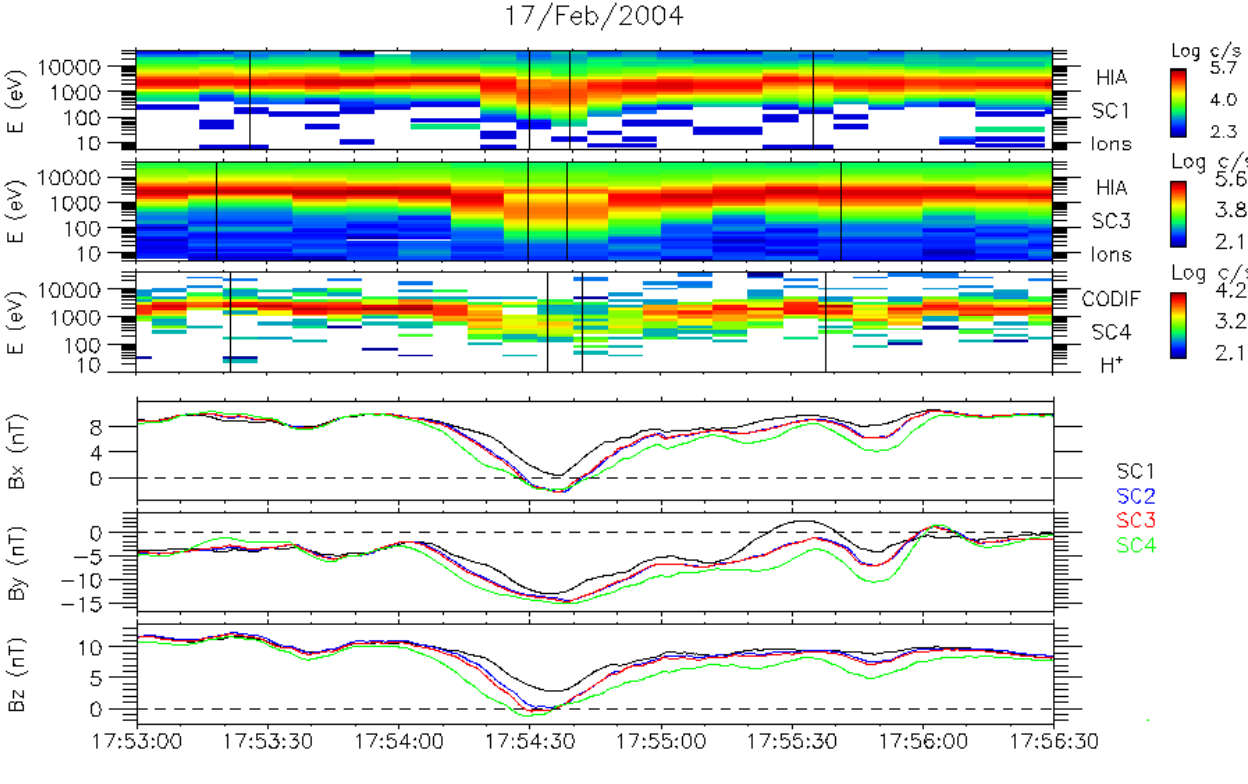
Fig. 5. 17 February 2004 from 17:53UT to 17:56:30UT. From top to bottom: Energy-time spectrogram from HIA for all ions, spacecraft 1. Energy-time spectrogram from HIA for all ions, spacecraft 3. Energy-time spectrogram from CODIF for O + ions, spacecraft 4. Magnetic field B X component in the GSE frame for the 4 Cluster spacecraft for Cluster 1 (black), Cluster 2 (blue), Cluster 3 (red) and Cluster 4 (green) computed from FGM data. Magnetic field B Y component in the GSE frame for the 4 Cluster spacecraft with the same colour code computed from FGM data. Magnetic field B Z component in the GSE frame for the 4 Cluster with the same colour code spacecraft computed from FGM